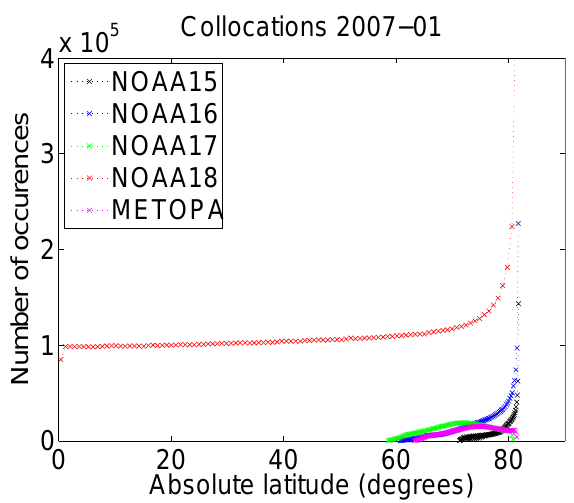
Fig. 3. A histogram of the number of collocations between the CloudSat CPR and the AMSU-B or MHS sensors on various satel- lites in January 2007. The maximum distance for a collocation is 15km; the maximum time between the collocated measurements is 15min (900s). The number of collocations refers to the number of CPR pixels collocating with an AMSU-B or MHS pixel.